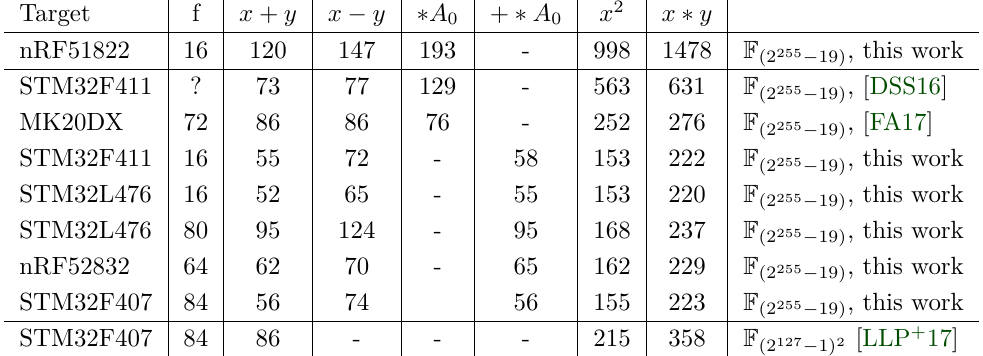
Table 4: Field arithmetic on different targets at different frequencies f (/MHz). Columns ∗ A 0 (+ ∗ A 0 ) contain clock cycles for multiplication with the field constant A 0 = 121666 and merged addition and multiplication x + y ∗ A 0 . Cycle count for the nRF51 target was obtained with the CLANG compiler with compile switch -O2 while for the